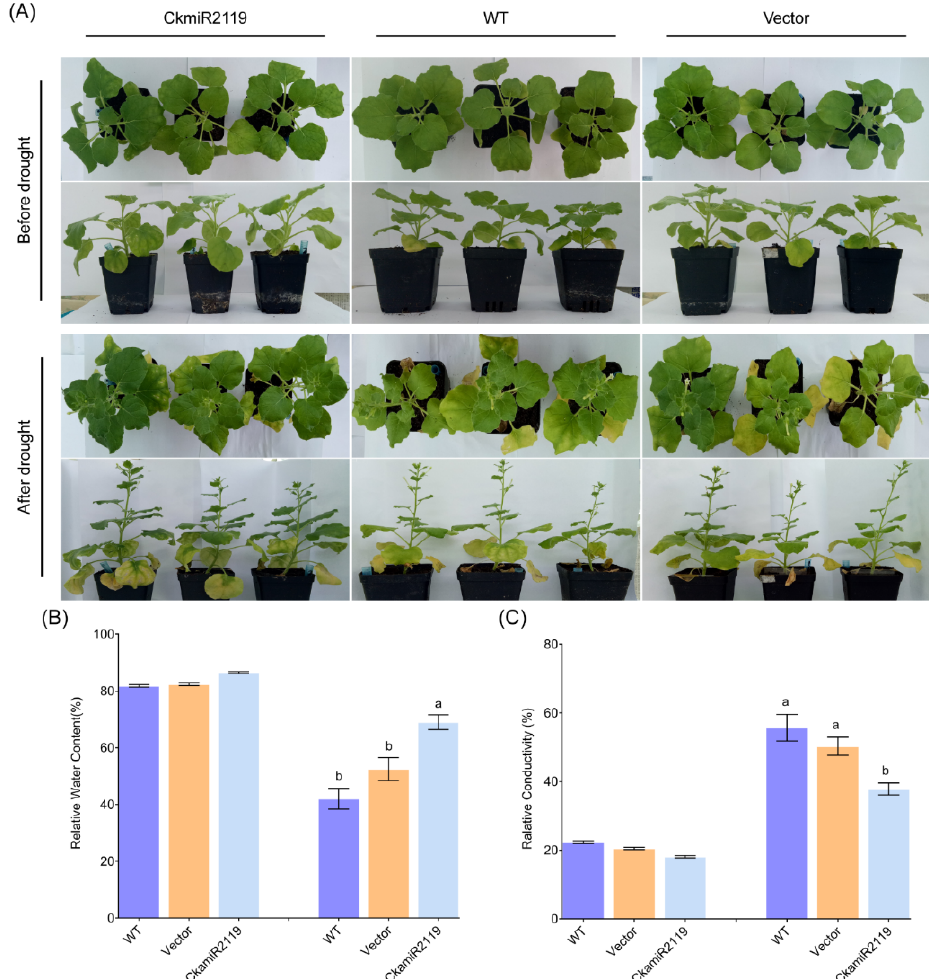
Figure 6. The phenotype of CkamiR2119 transgenic plants under drought treatment. ( A ) Phenotypic observations of drought treatment. ( B ) Relative water content of transgenic tobacco plants. ( C ) Relative conductivity of transgenic tobacco plants. Data are shown as the mean ± SD of three independent experiments. One-way ANOVA was performed for the statistical analysis, where different letters represent significant differences ( p < 0.05).